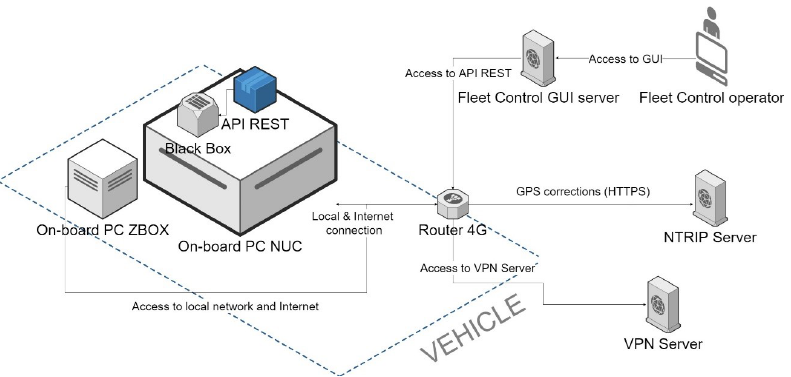
Figure 21. Autonomous Vehicle Communications